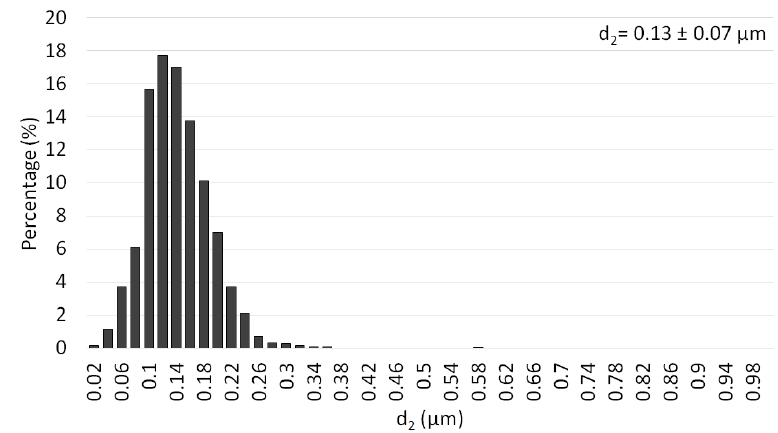
Figure 3. Histogram of the particle size distribution of the Al 2 O 3 powder.